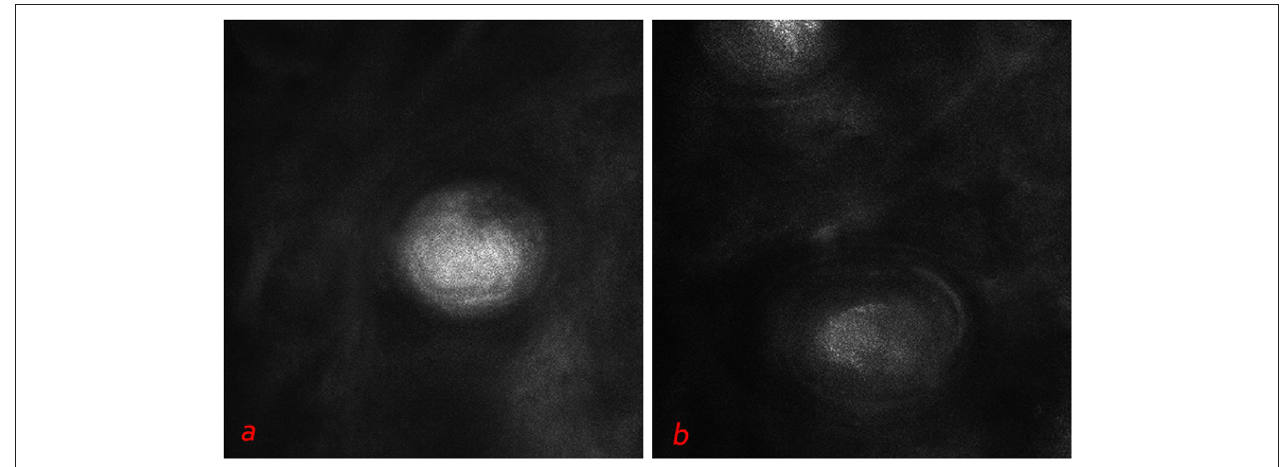
FIGURE 5 | Deeper level imaging of syringoma of vulva area (a,b) showed that the refraction of the round structures tends to be slightly decreased as they go deep.